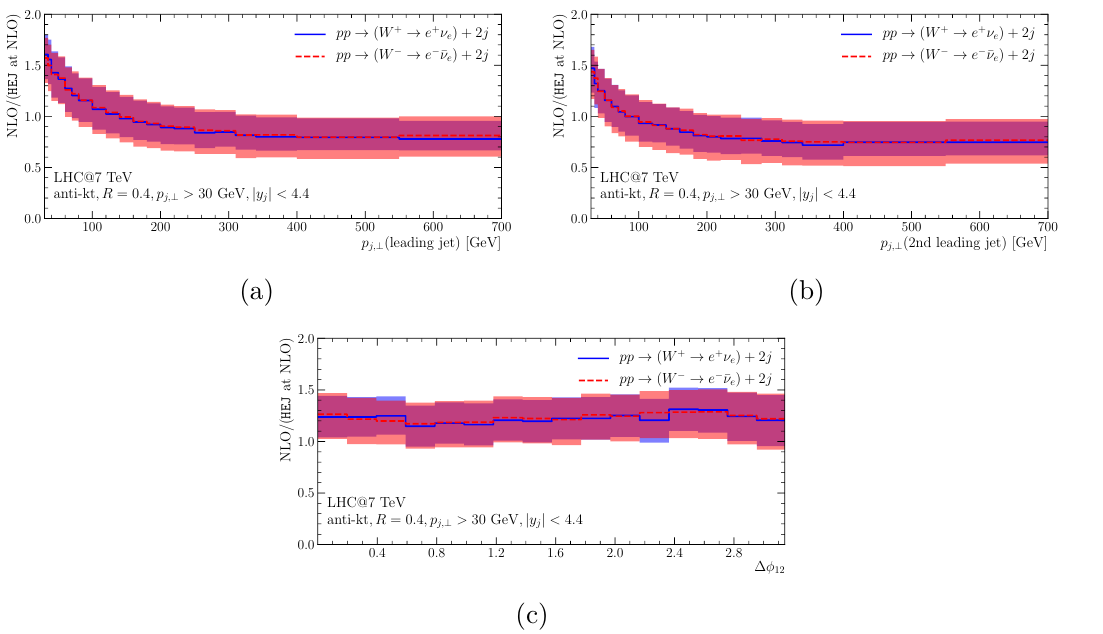
Figure 15. The NLO matching corrections obtained for the following distributions presented in ref. [14] for inclusive W + + 2 j production (blue, solid) and W − + 2 j production (red, dashed): (a) transverse momentum of the leading jet, (b) transverse momentum of the second jet and (c) the difference in azimuthal angle between the leading two jets.